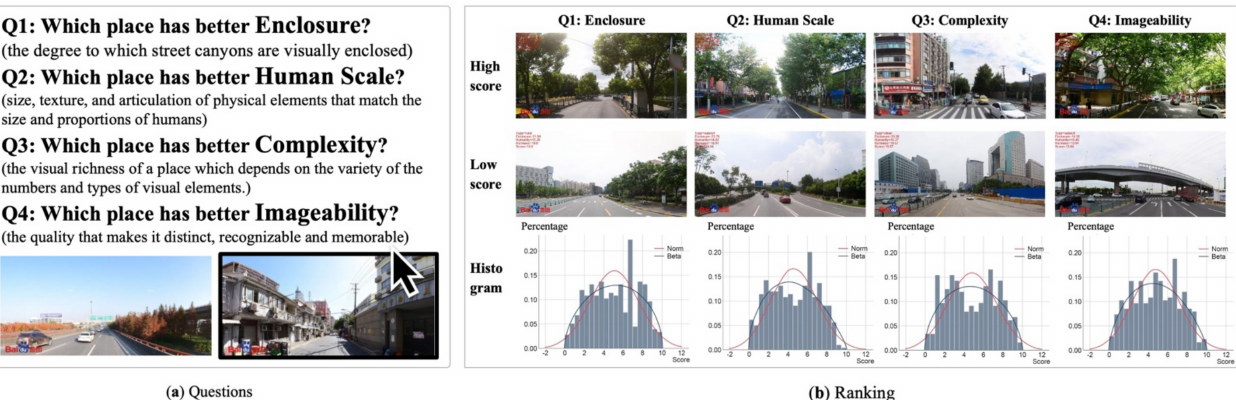
Figure 3. Collecting collaborative images of streetscapes with an online survey platform. ( a ) Our online survey system asked participants to click on one imagine in a pair of SVIs in response to evaluative questions. ( b ) High score and low score example images as well as the histogram of score distribution for each of the four perceived street